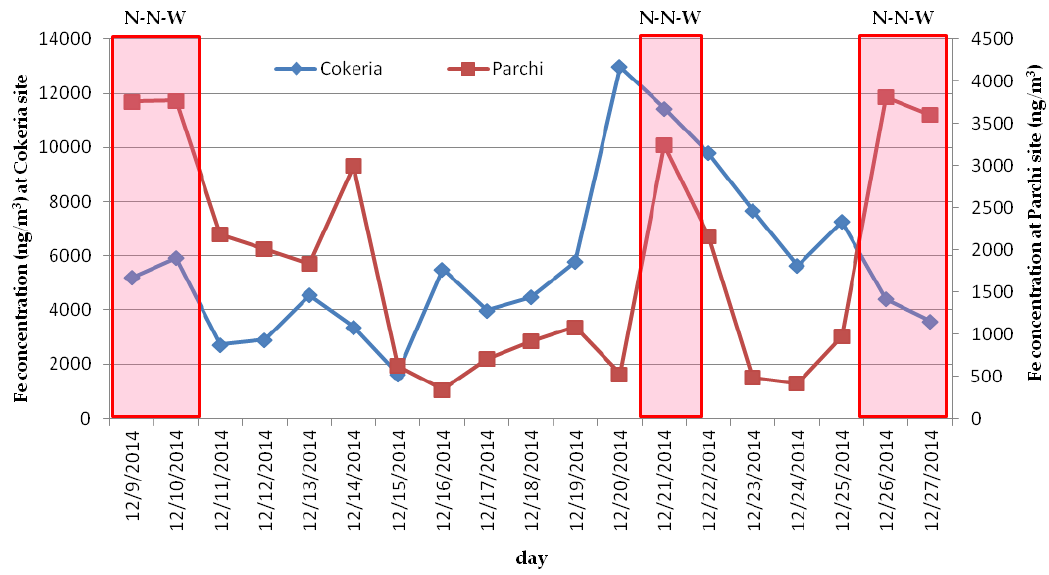
Figure 2. Fe daily concentration trends at Cokeria and Parchi sites from 9 to 27 December 2014 (last day of sampling period missing) and prevailing wind direction in selected days.